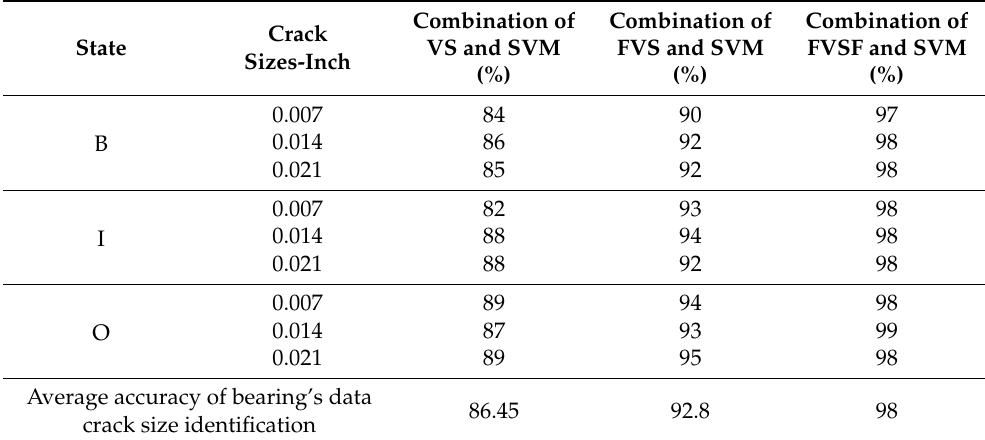
Table 6. Comparison of the combination of VS and SVM, the combination of FVS and SVM, and the combination of the proposed FVSF and SVM for bearing crack size